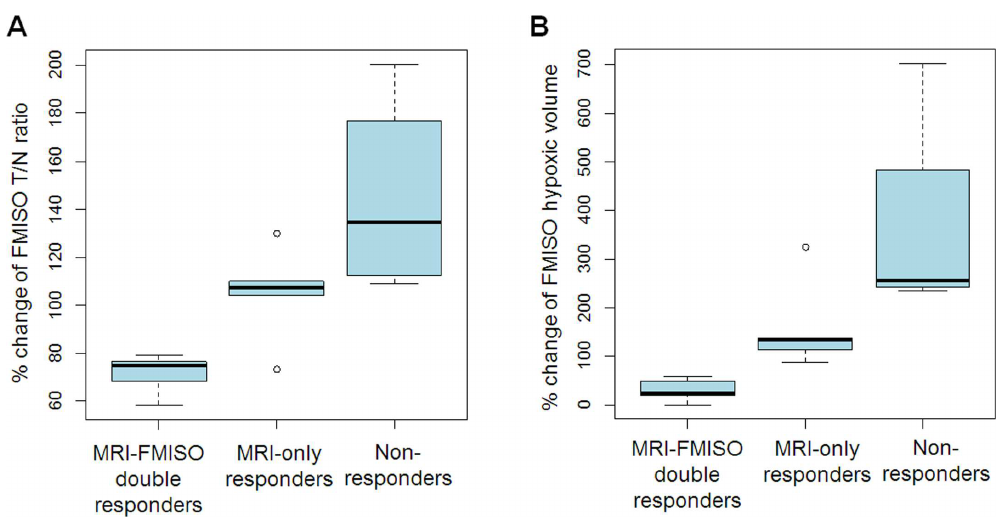
Fig 2. FMISO Accumulation change after 3–4 courses BEV treatment. Percentagechangeof FMISO accumulationT/N ratio (A) and volume (B) accordingto the classification by MRI and FMISO PET